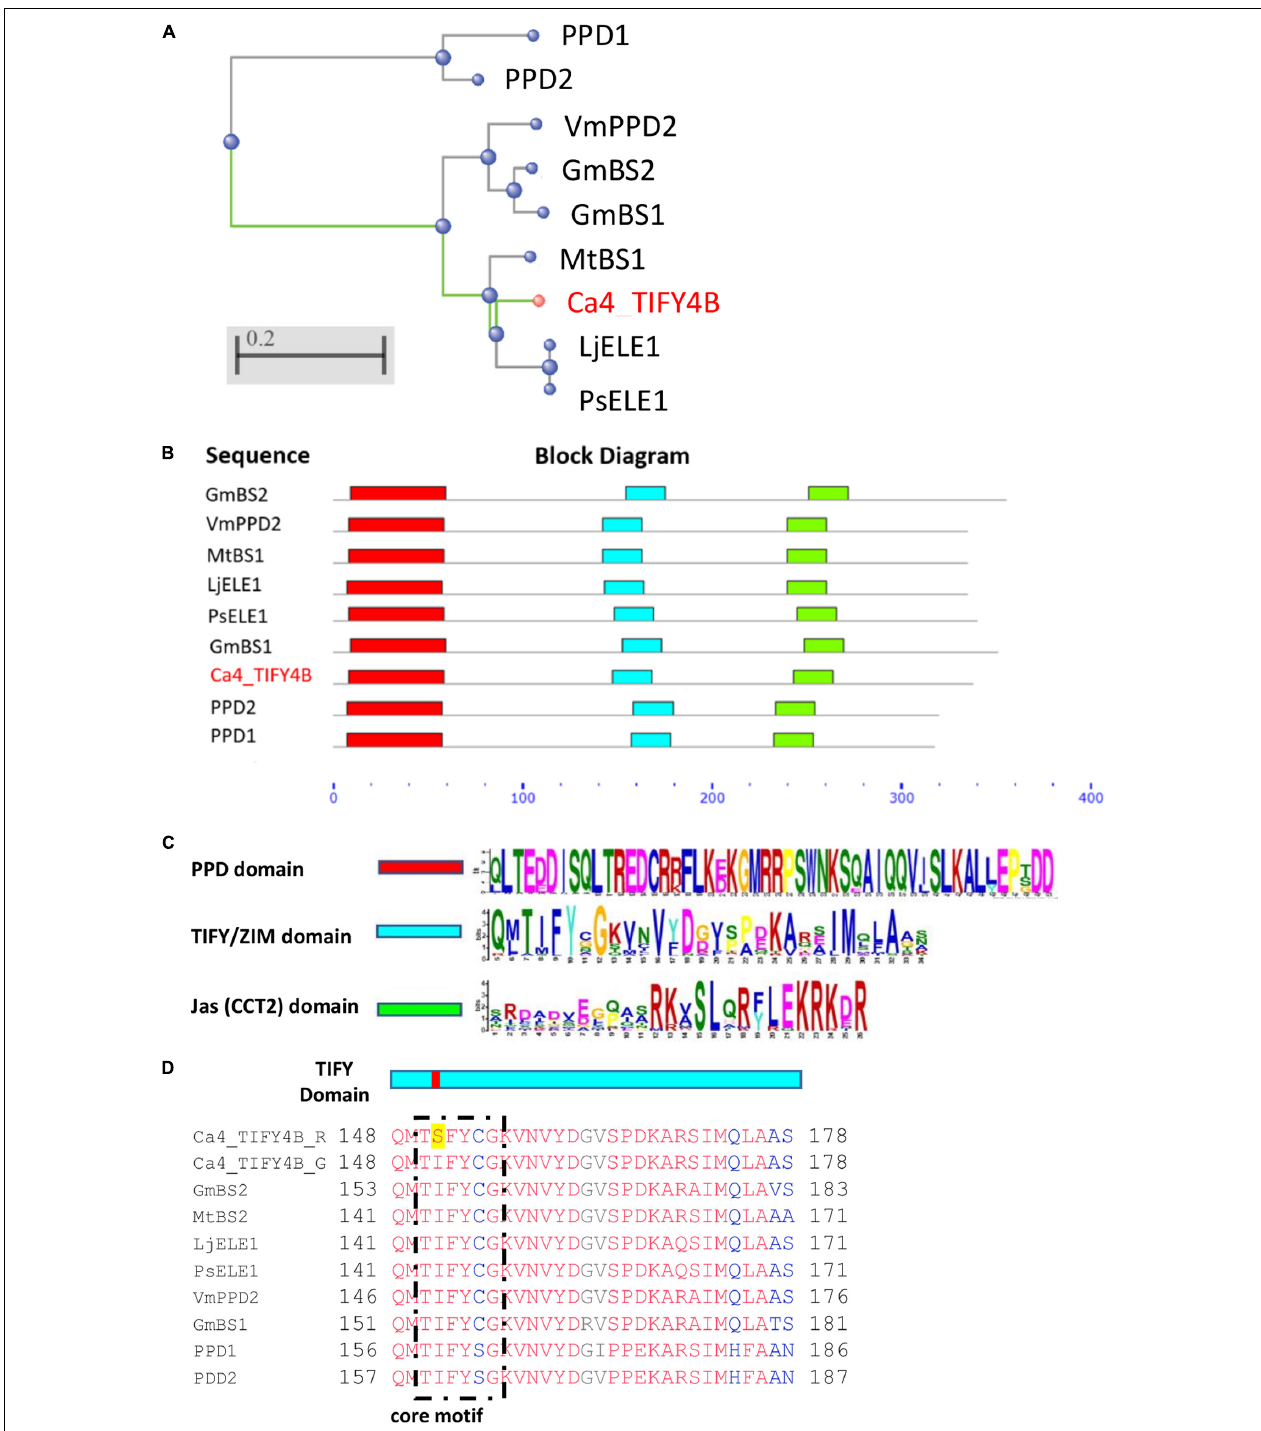
FIGURE 4 | (A) Phylogenetic relationship of Ca4_TIFY4B protein sequence with orthologs from other plant species: G. max , BS1, BS2, V. mungo , VmPPD; M. truncatula , BS1; P. sativum , ELE1; Lotus japonicus , ELE1; A. thaliana , PPD1 and PPD2. Data were analyzed via Constraint-based Multiple Alignment Tool [COBALT, Papadopoulos and Agarwala (2007)]. The tree was created using a neighbor-joining method (Saitou and Nei, 1987). Cluster distance scale is shown on the gray bar (0.2) (B) Putative conserved domain structure in the CaTIFY4B protein and its homologs in other species, assessed using the Multiple Expectation maximization for Motif Elicitation (MEME) web server (https://meme-suite.org/meme/). The blue scale indicates amino acid sequence length; the color blocks represent the positions of domains. (C) The consensus sequences of conserved domains for TIFY, Jas (CCT2), and PPD from TIFY family proteins were created using MEME. (D) Sequence alignment across the TIFY domain. The isoleucine/serine (I/S) substitution in Ca4_TIFY4B_R is highlighted.